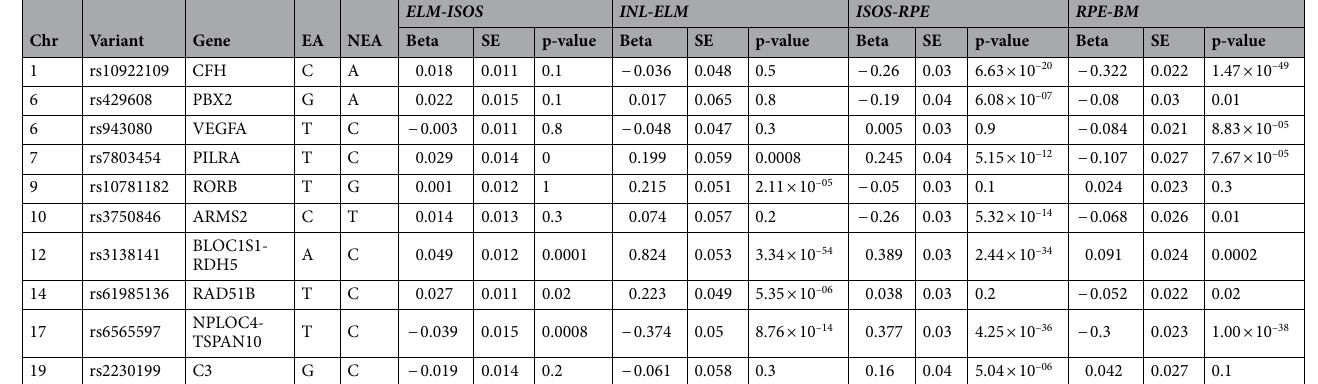
Table 1. Significant associations between average SD-OCT measurements and AMD variants. Columns “Variant”, “EA” and “NEA” list variants that were included in the model, and their risk alleles (EA, effect alleles for which the effect sizes are reported and NEA, non-effect alleles). Fields “Beta”, “SE” and “P” denote the change in SD-OCT measurements, standard errors and p-values of observed associations. The table includes significant linear regression results for 32,113 unrelated participants from UK Biobank participants. Models were adjusted for sex, age, spherical equivalent, smoking